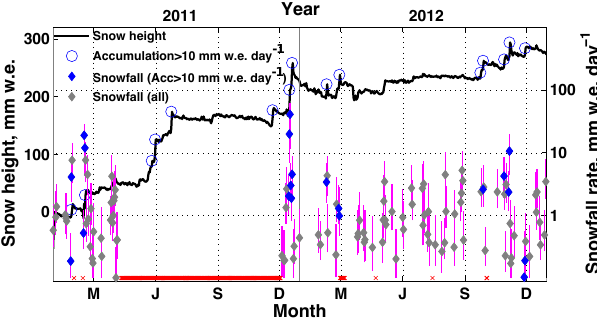
Figure 8. Daily snow height (with respect to 1 January 2011) and snowfall rate ( S ) during 2011–2012. High-accumulation events ( > 10mmw.e.day − 1 ) are marked with blue circles and correspond- ing snowfall events – with blue diamonds. Grey diamonds show all other snowfall events. Vertical magenta lines show uncertainty in S for a range of Z e – S relationships for dry snow (Table 5; Sect. 3.2). Horizontal red bar and crosses at bottom indicate gaps in snowfall measurements. Letters on x axis mark the first day of each